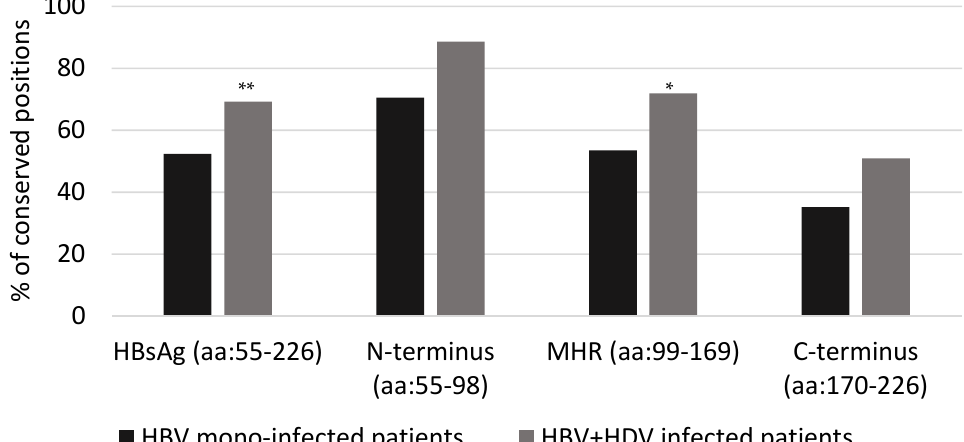
Figure 1. The histogram reports the percentage of conserved HBsAg positions in 31 HBV + HDV coinfected patients (grey bars) and 62 HBV mono-infected patients (black bars). Conserved positions are those with Shannon Entropy = 0. Statistically significant differences were assessed by Chi Square Test. ** p = 0.001; * p =